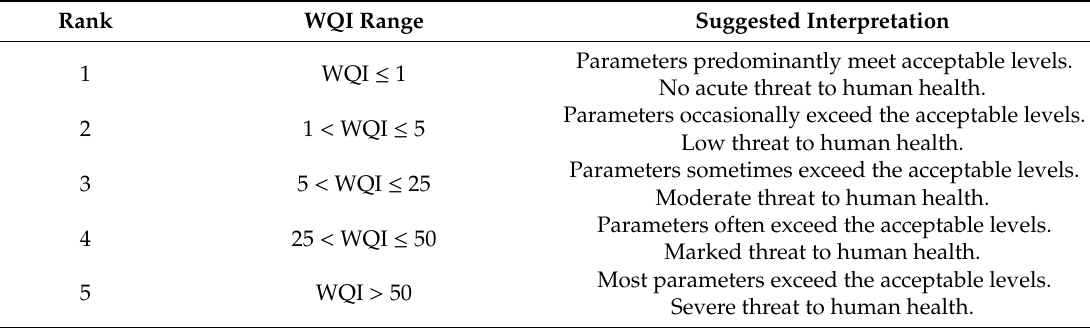
Table 1. Classification of drinking water quality based on the WQI